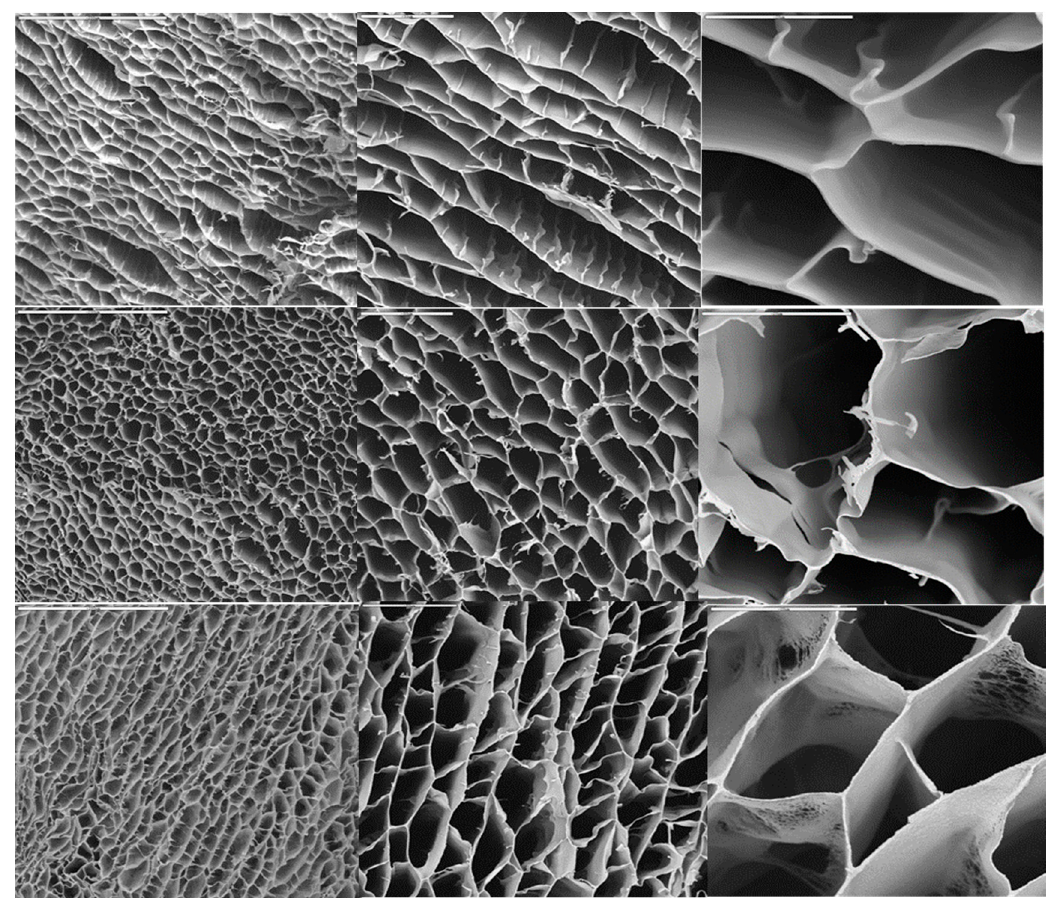
Figure 1. SEM micrographs of different hierarchical structures resulting from freezing samples with different CS/CaP ratios. CSCaP1 ( upper line ), CSCaP2 ( middle line ) and CSCaP3 ( bottom line ). From left to right, bars are 200, 50 and 20 µ m, respectively.